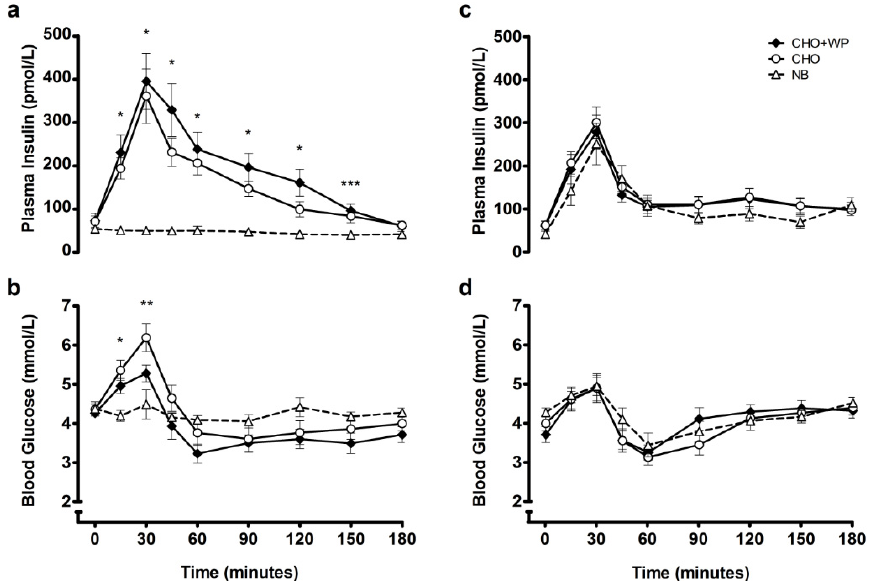
Figure 2. Mean ± SEM temporal changes in plasma insulin ( a ) and blood glucose ( b ) during the post-breakfast period, and plasma insulin ( c ) and blood glucose ( d ) during the post-lunch period. Significant differences ( p < 0.05) between trials at individual time points are defined as follows: * NB vs. CHO + WP and CHO, ** NB vs. CHO, *** NB vs. CHO + WP. CHO: high-carbohydrate breakfast trial; CHO + WP: high-carbohydrate breakfast with added whey protein trial; NB: no breakfast